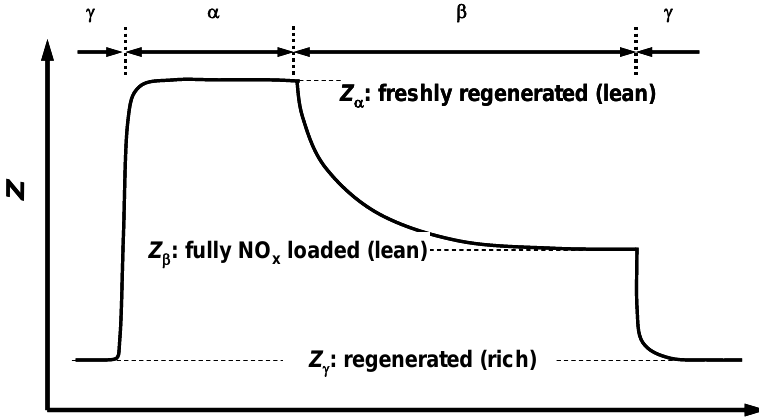
Figure 3. Sketch of the electrical impedance of LNT materials at 350 °C. Simplified after Refs. [20] and